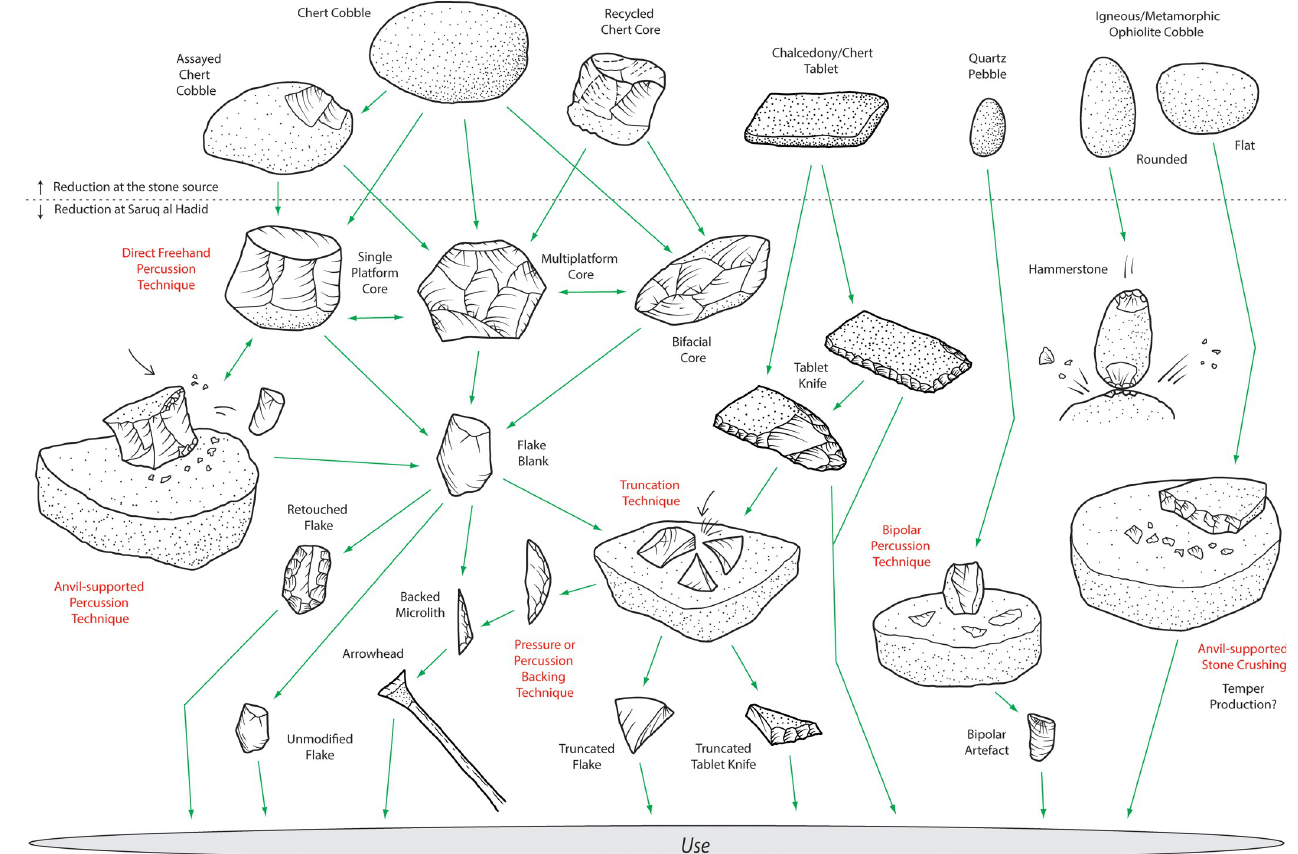
Fig 3. Stone reduction sequence model, Horizon IV, Saruq al-Hadid.